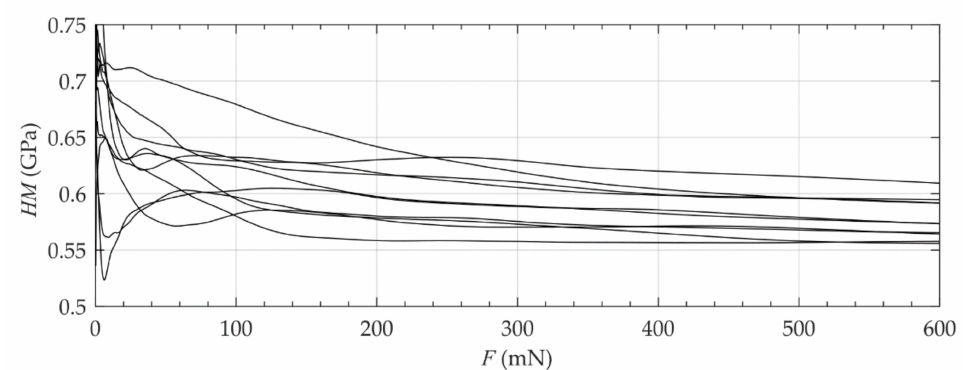
Figure 3. Influence of the maximum applied test force (10 measurements on the cutting surface of the tooth).